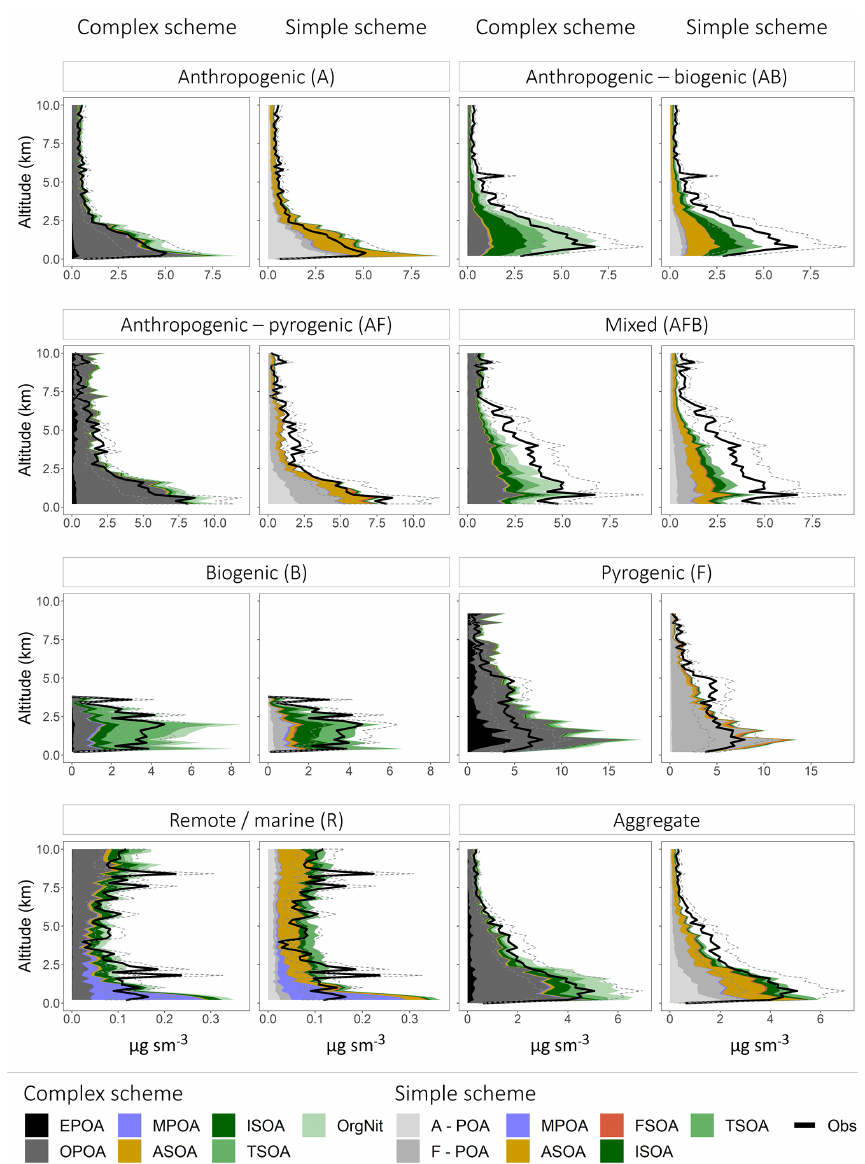
Figure 8. Mean vertical profiles (in kilometers) comparing the observed (black) and simulated (colored) OA mass concentrations classified into the different regimes. The dashed lines represent the uncertainty in the observed OA mass loadings. The profiles are binned at 200m intervals. For the simple scheme, A-POA represents anthropogenic POA and F-POA represents pyrogenic POA. Refer to the text for other OA categories and details on model